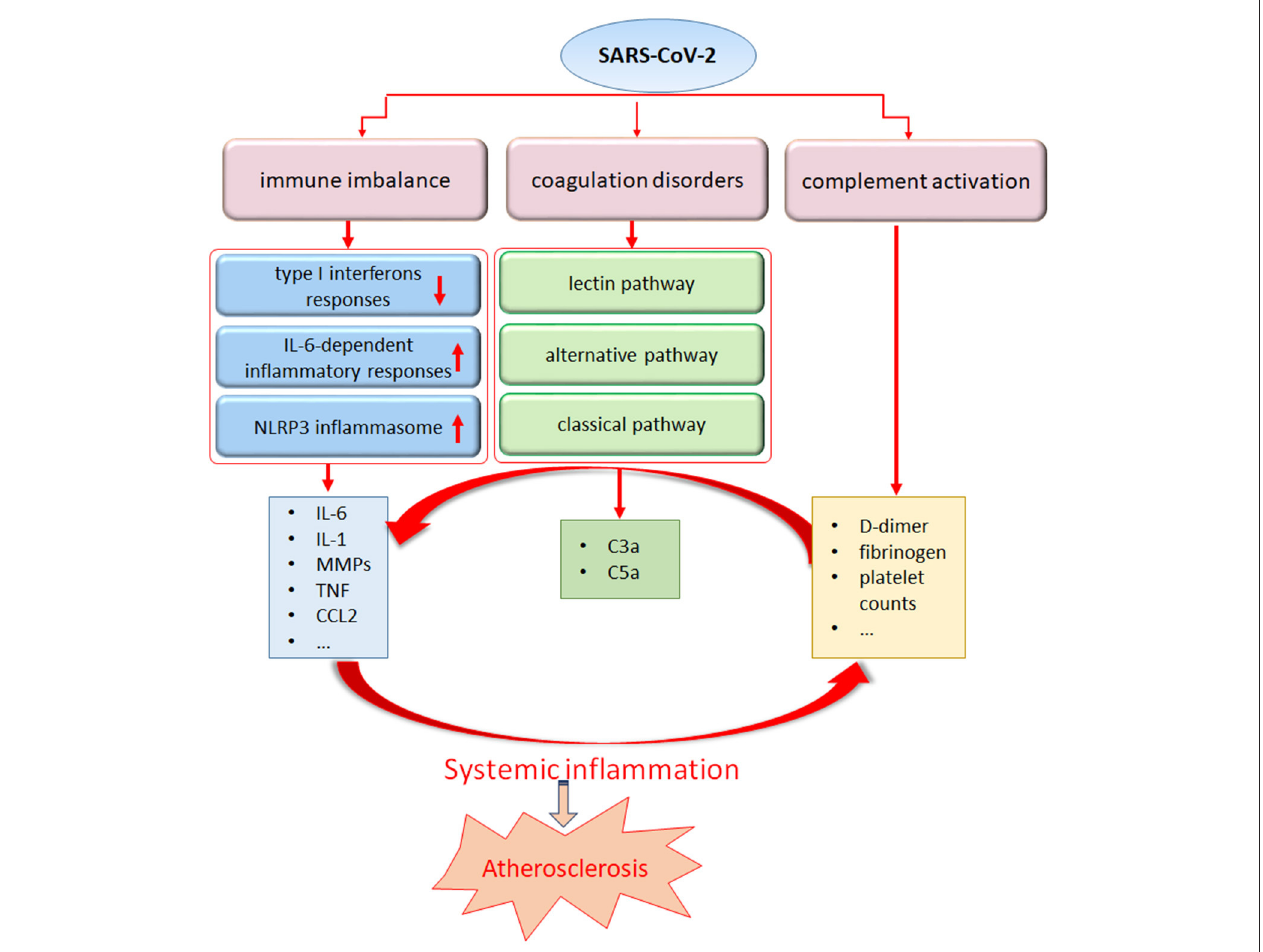
FIGURE 2 | The systemic inflammatory response from SARS-Cov-2 may trigger atherosclerosis. SARS-CoV-2 infection can stimulate a pronounced immune response including dysregulation of interferon and IL-6 pathway, NLRP3 inflammasome activation, leading to an uncontrolled production of proinflammatory mediators. In addition, coagulation disorders and complement abnormalities induced by SARS-CoV-2 infection may contribute to the maladaptive inflammatory